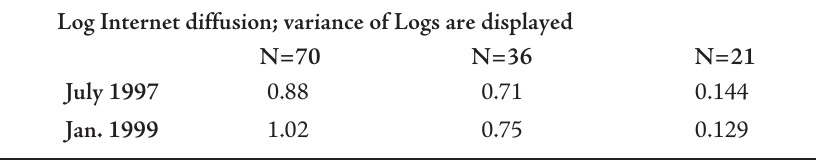
Table 4 – Evidence for divergence in Internet usage diffusion in the world* Log Internet diffusion; variance of Logs are